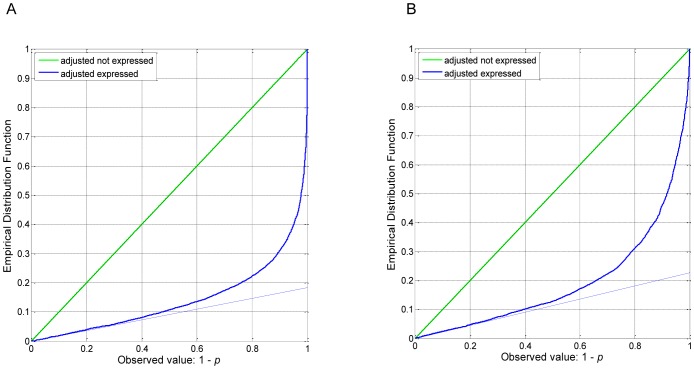
P-value plot for the null hypothesis of no difference in gene expression between heart tissues from DOX treated rats versus heart tissues from control rats (A) and PBMC tissues from DOX treated rats versus PBMC tissues from control rats (B).